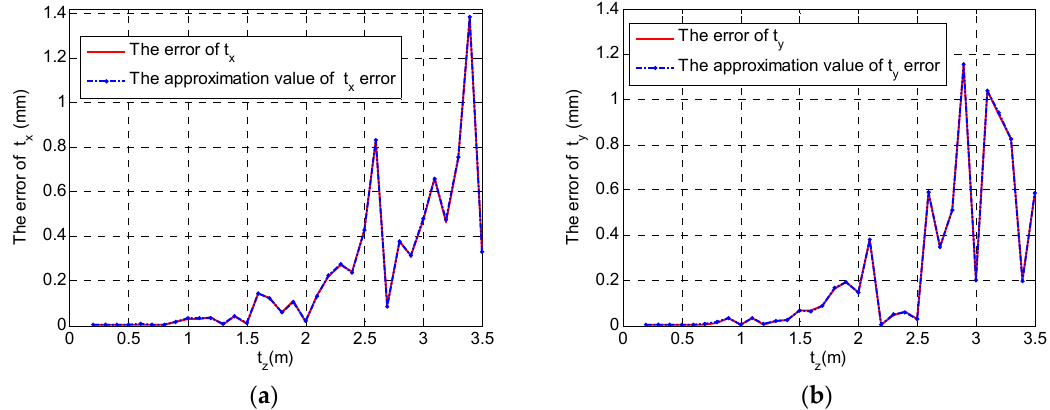
t error analysis. t error analysis; ( b ) y x